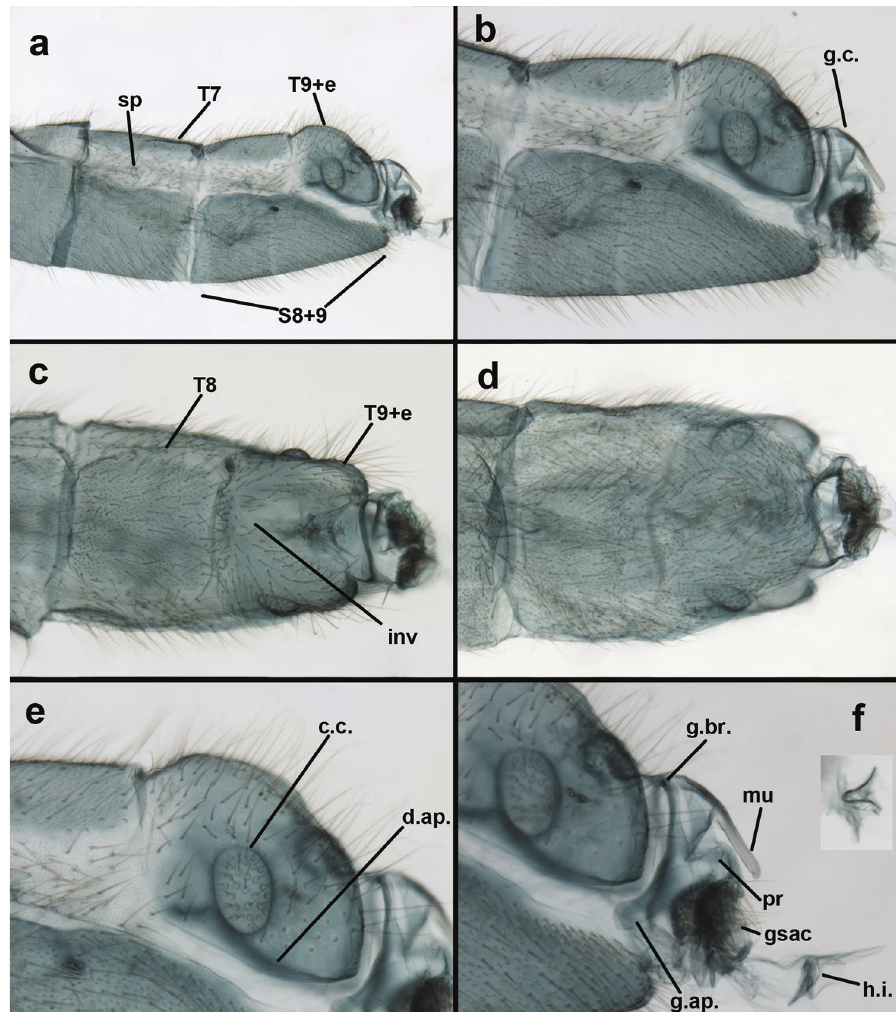
Figure 70. Ungla pallescens Penny: Male abdomen and genitalia (slightly teneral), ( a ) segments A7-ter- minus, lateral ( b ) segments A8-terminus, lateral ( c ) segments A8, T9+ectoproct, dorsal ( d ) sternite 8+9, ventral ( e ) T9+ectoproct, lateral ( f ) gonarcal complex, lateral [insert: hypandrium internum, dorsal; same scale as gonarcus]. c.c. callus cerci d.ap. apodeme on ventral margin of T9+ectoproct gsac gonosaccus g.ap. gonarcal apodeme g.br. gonarcal bridge g.c. gonarcal complex h.i. hypandrium internum inv in- vaginated dorsal cleft in T9+ectoproct mu mediuncus pr unarticulated process on frontal margin of gonarcal apodeme sp spiracle S8+9 fused eighth and ninth sternites T7, T8 seventh and eighth tergites T9+e ninth tergite + ectoproct (Costa Rica, Monteverde, paratype,